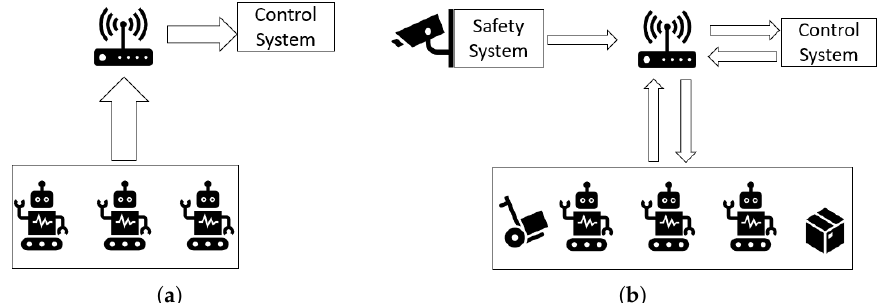
Figure 1. A robot pose determination: ( a ) Nowadays robots inform control systems about their pose; ( b ) Proposed method of determination of any device pose, robots may provide their own pose estimation so two-way detection is performed.